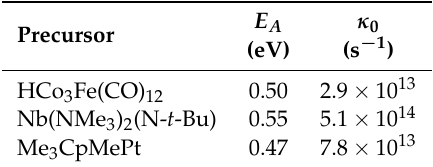
Table 2. Table of activation energies and pre-exponential factors for the CoFe-, Nb-, and Pt-precursor on Si/SiO 2 as substrate